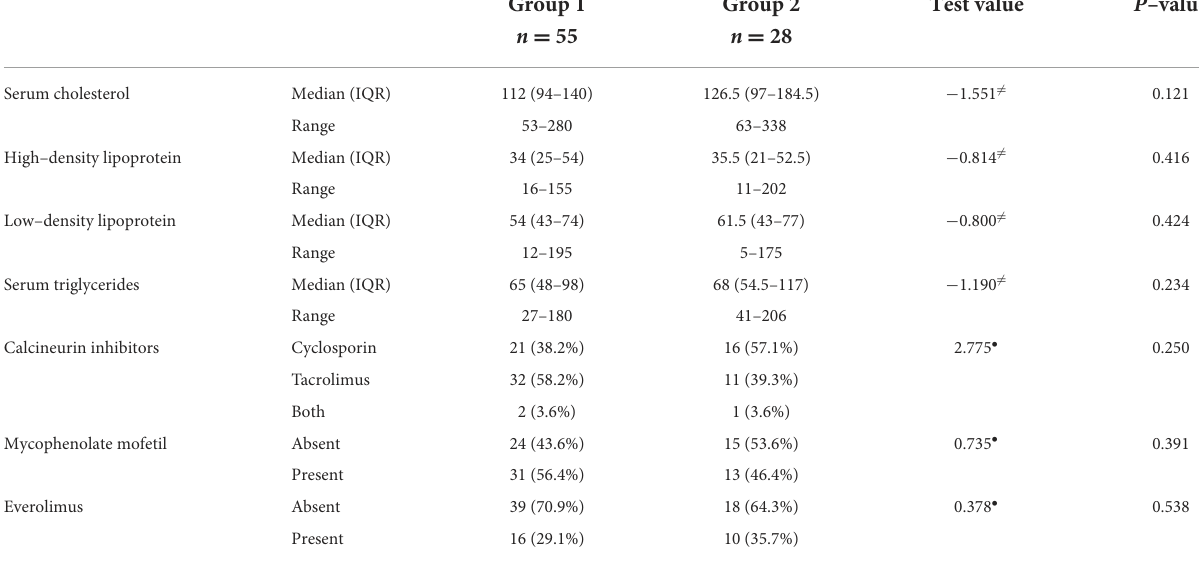
TABLE 4 Lipid profile and the type of immune suppression used in the study